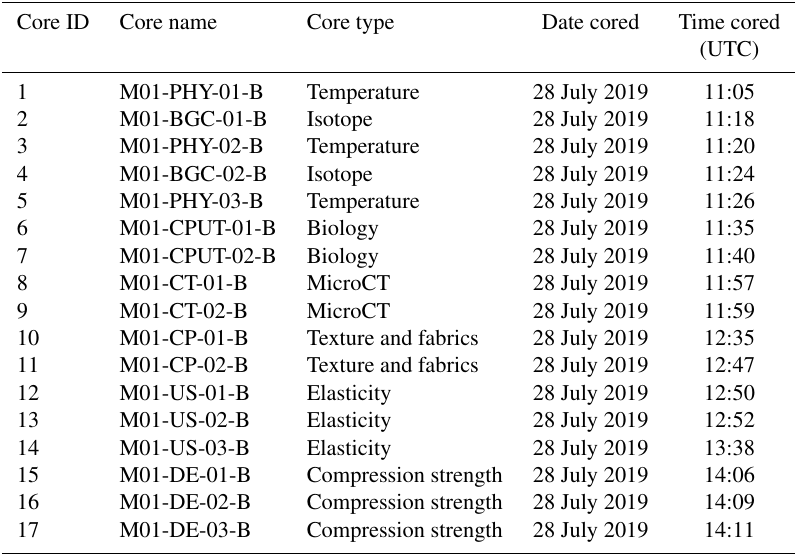
Table A3. Overview of core IDs of Pancake B, corresponding core names, testing designation, and date and time when cored.